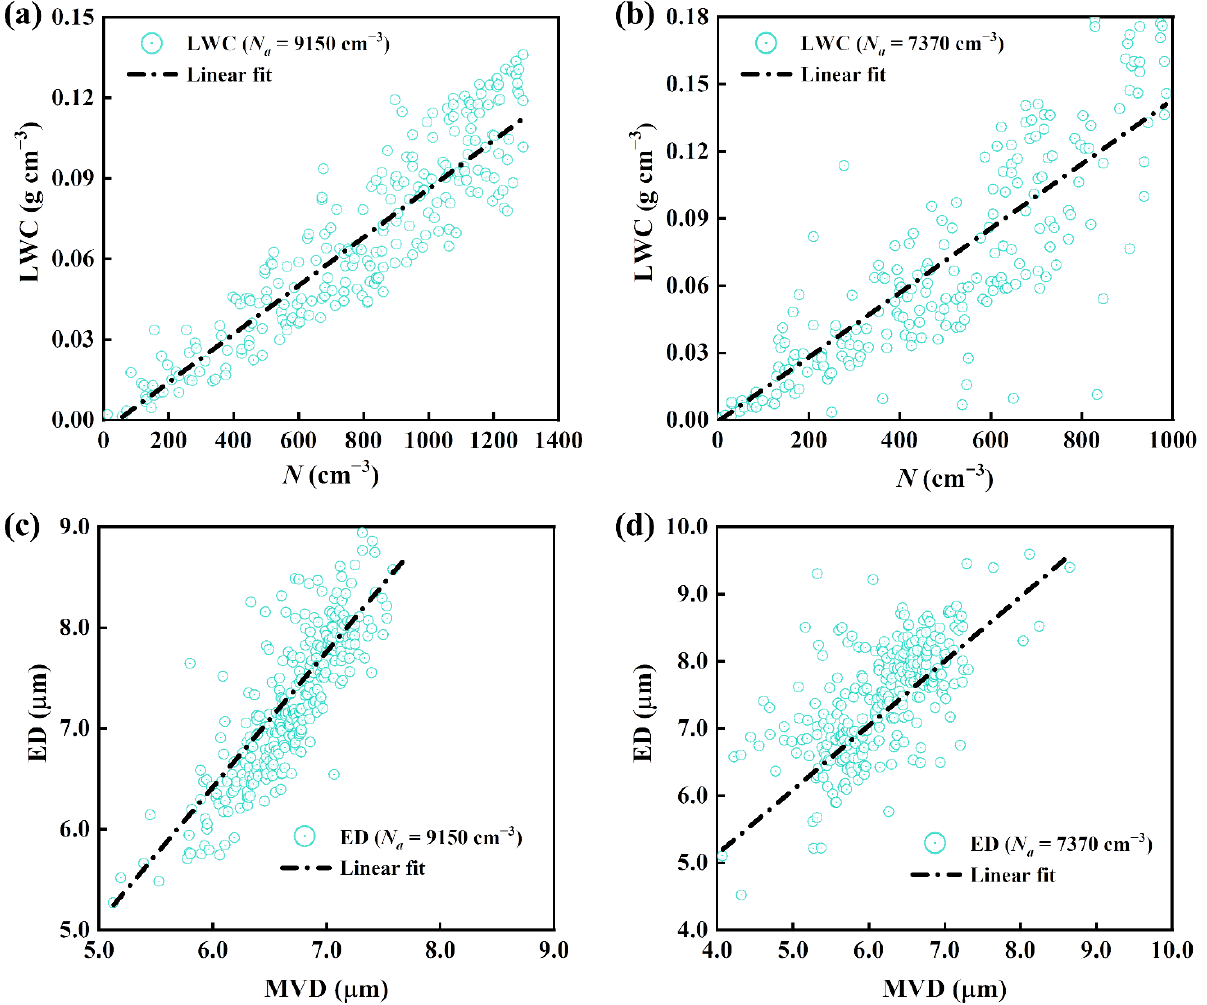
Figure 13. Microphysical parameter correlation curves are shown for N a of 9150 and 7370 cm − 3 , respectively. ( a , b ) show the relationship between N and LWC. ( c , d ) show the relationship between ED and MVD.